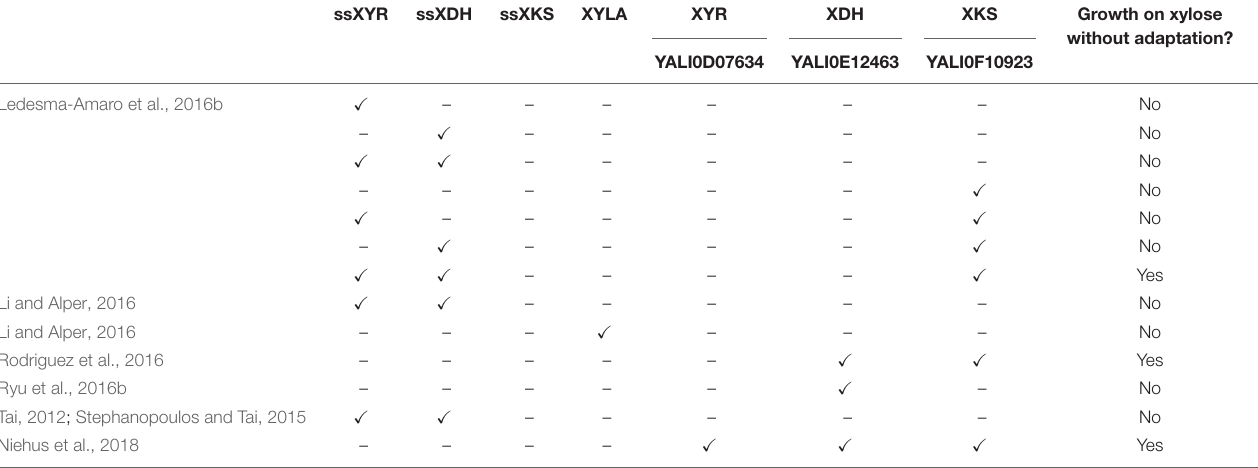
TABLE 1 | Summary of recent studies on native and engineered xylose metabolism in Yarrowia lipolytica